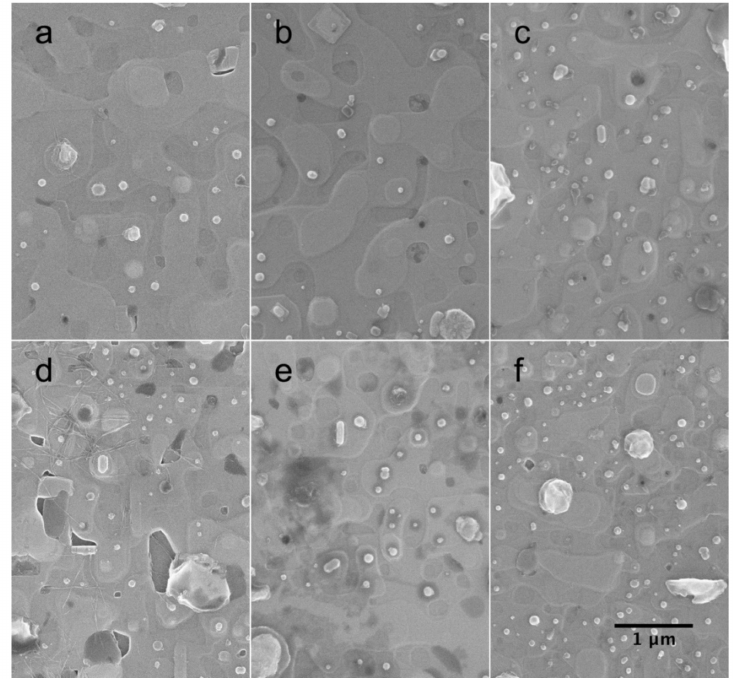
Figure 5. SEM images at the same magnification of ( a ) YBCO, ( b ) YBCO-Gd 5%, and ( c ) YBCO-Gd 10% films deposited by the standard process; ( d ) YBCO, ( e ) YBCO-Gd 5%, and ( f ) YBCO-Gd 10% films deposited by the fast process. Scale bar: 1 µ m.